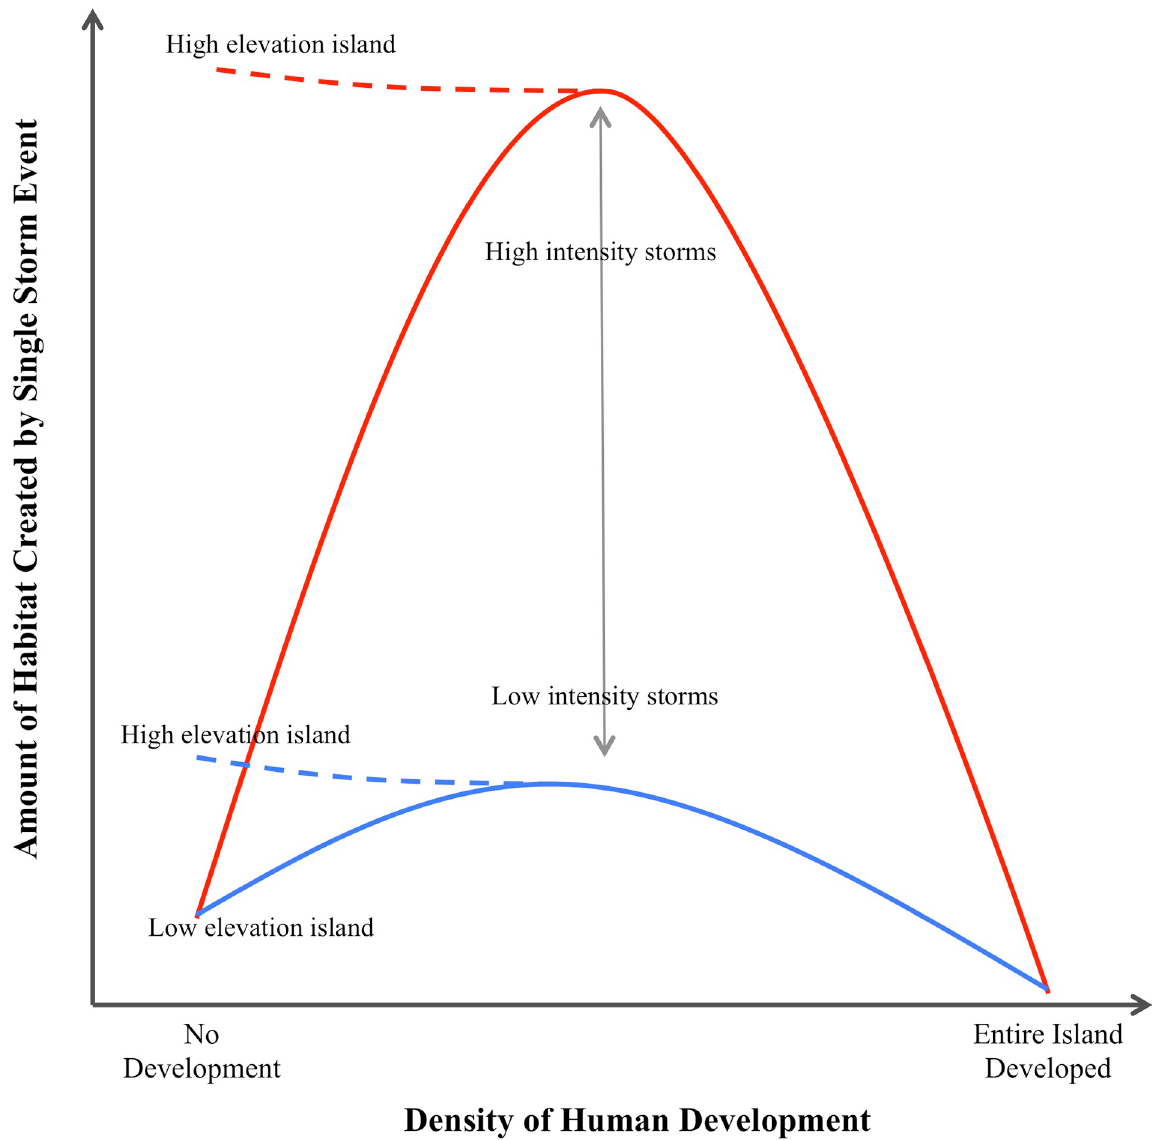
Fig 10. Proposed relationship between the density of human development across a barrier island and the amount of early successional habitat created by a single low intensity (blue line) or high intensity (red line) storm event. In this relationship, no single storm event will have a major impact on the amount of early successional habitat on low elevation, undeveloped islands because smaller intensity storms maintain maximum amounts of habitat through time. A single storm will also have a minor impact on habitat on islands with a high density of human development because shoreline modifications prevent overwash and encourage erosion, minimizing the ‘opportunity space’ for new habitats to be created. On high elevation, undeveloped islands (dashed lines) or on islands with moderate levels of development (middle of x- axis), less frequent high-intensity storms are needed to create overwash and new habitats; however, undeveloped stretches of shoreline provide opportunities for habitat to be created. As a result, a large storm like Hurricane Sandy can have a major impact in the amount of habitat